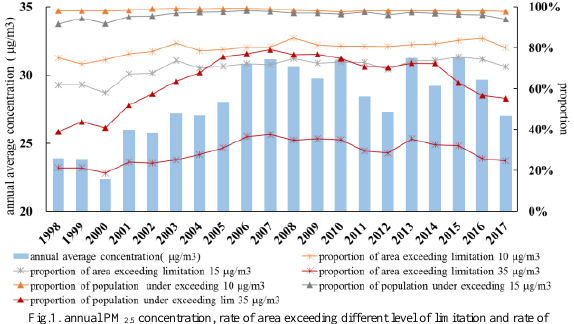
Fig.1. annual PM 2.5 concentration, rate of area exceeding different level of limitation and rate of population exceeding different level of limitation during 1998 to